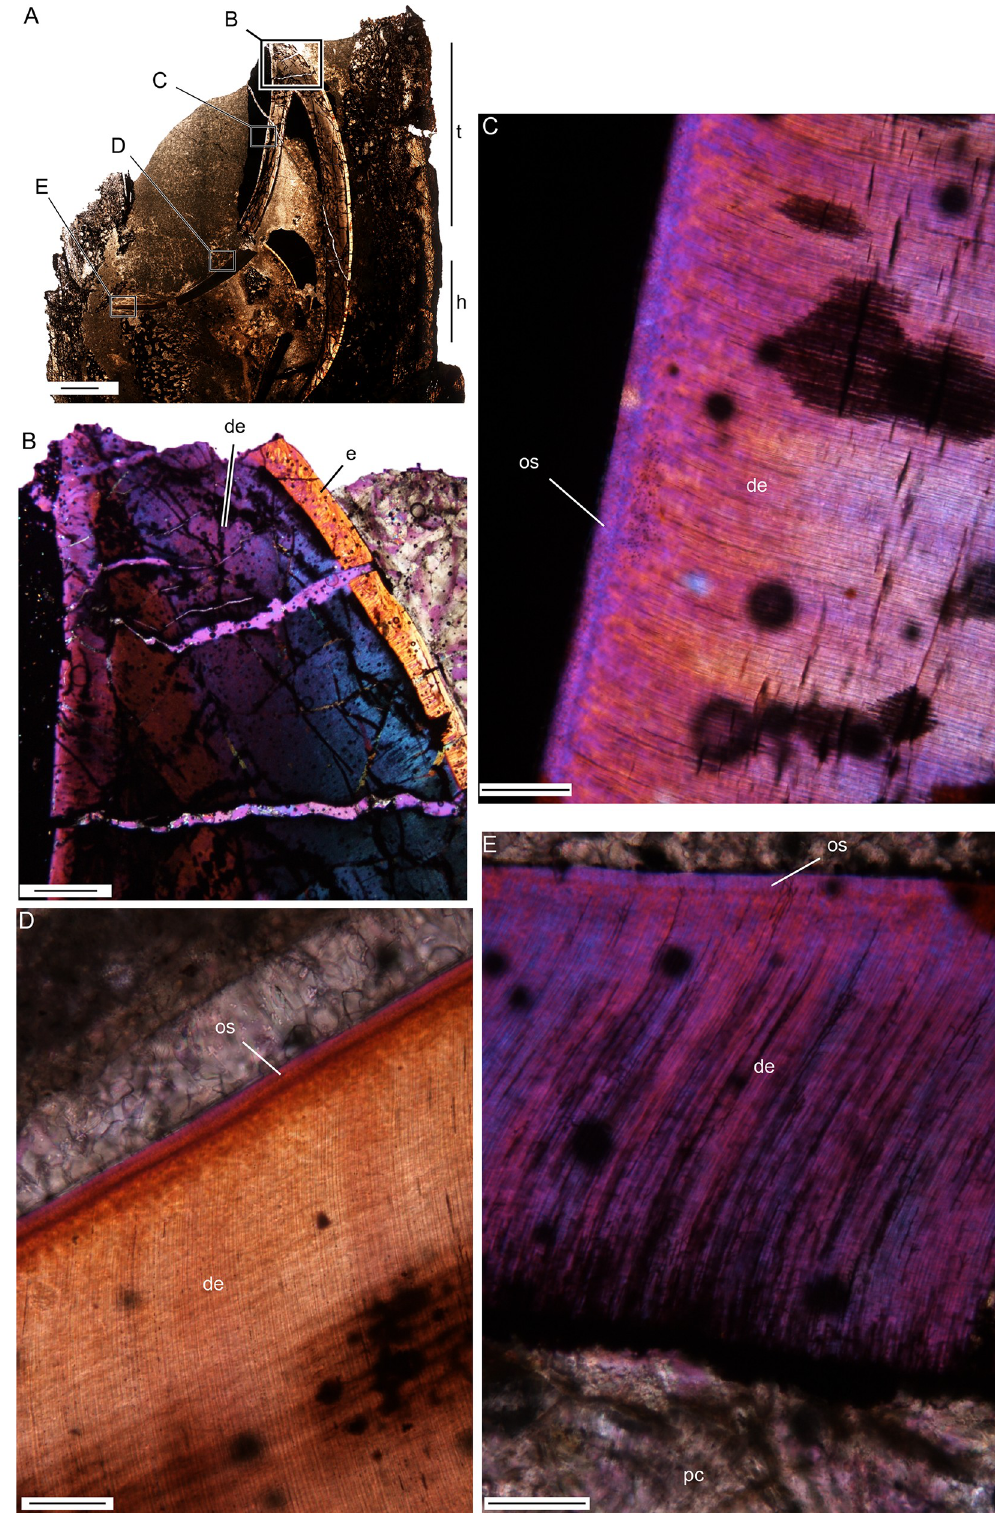
Fig 5. Developing tooth in the second incisor position of NHCC LB370 with no enamel deposition along the occlusal surface. (A) Sagittal section through the tooth demonstrating heel and talon development, with locations of